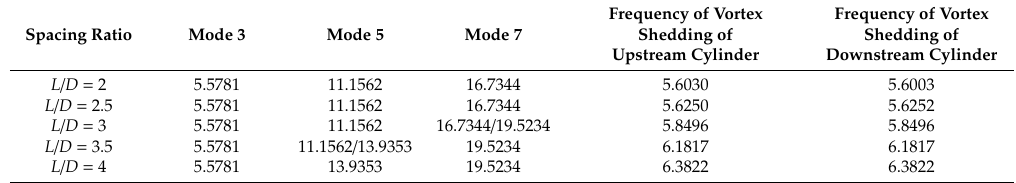
Table 3. Dominant frequency obtained by Fourier power spectra of the main POD modes at di ff erent spacing